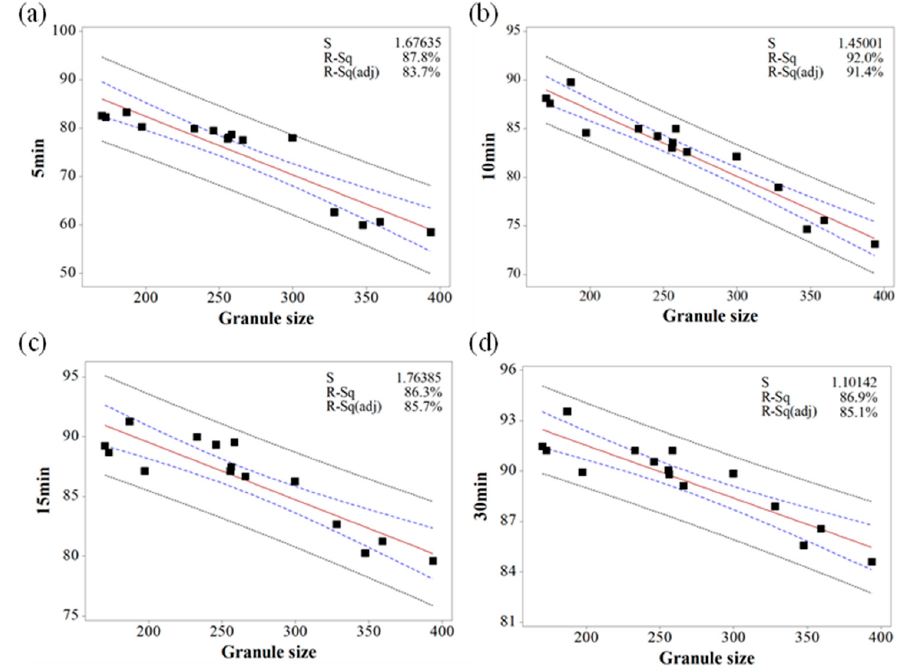
Figure 11. The fitted line plots of % dissolution (( a ) 5 min, ( b ) 10 min, ( c ) 15 min, and ( d ) 30 min) versus granule size. The black dots, red line, blue dotted line, and black dotted line represent the experimental results, best fitted regression, 95% confidence intervals, and 95% prediction intervals, respectively.